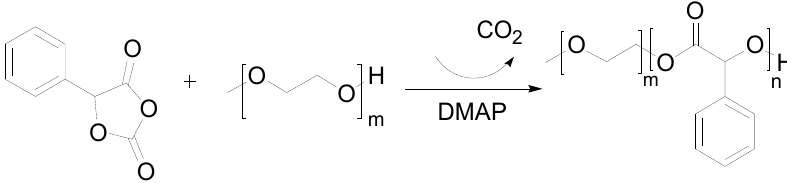
Figure 10. Reaction mechanism of preparing mandelic acid O-carboxyanhydride (Mac-OCA).